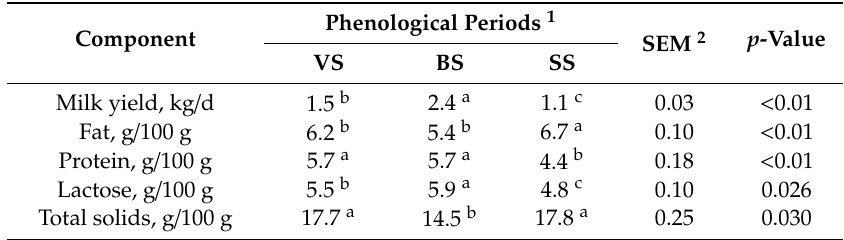
Table 3. Composition of yak milk in di ff erent phenological periods.